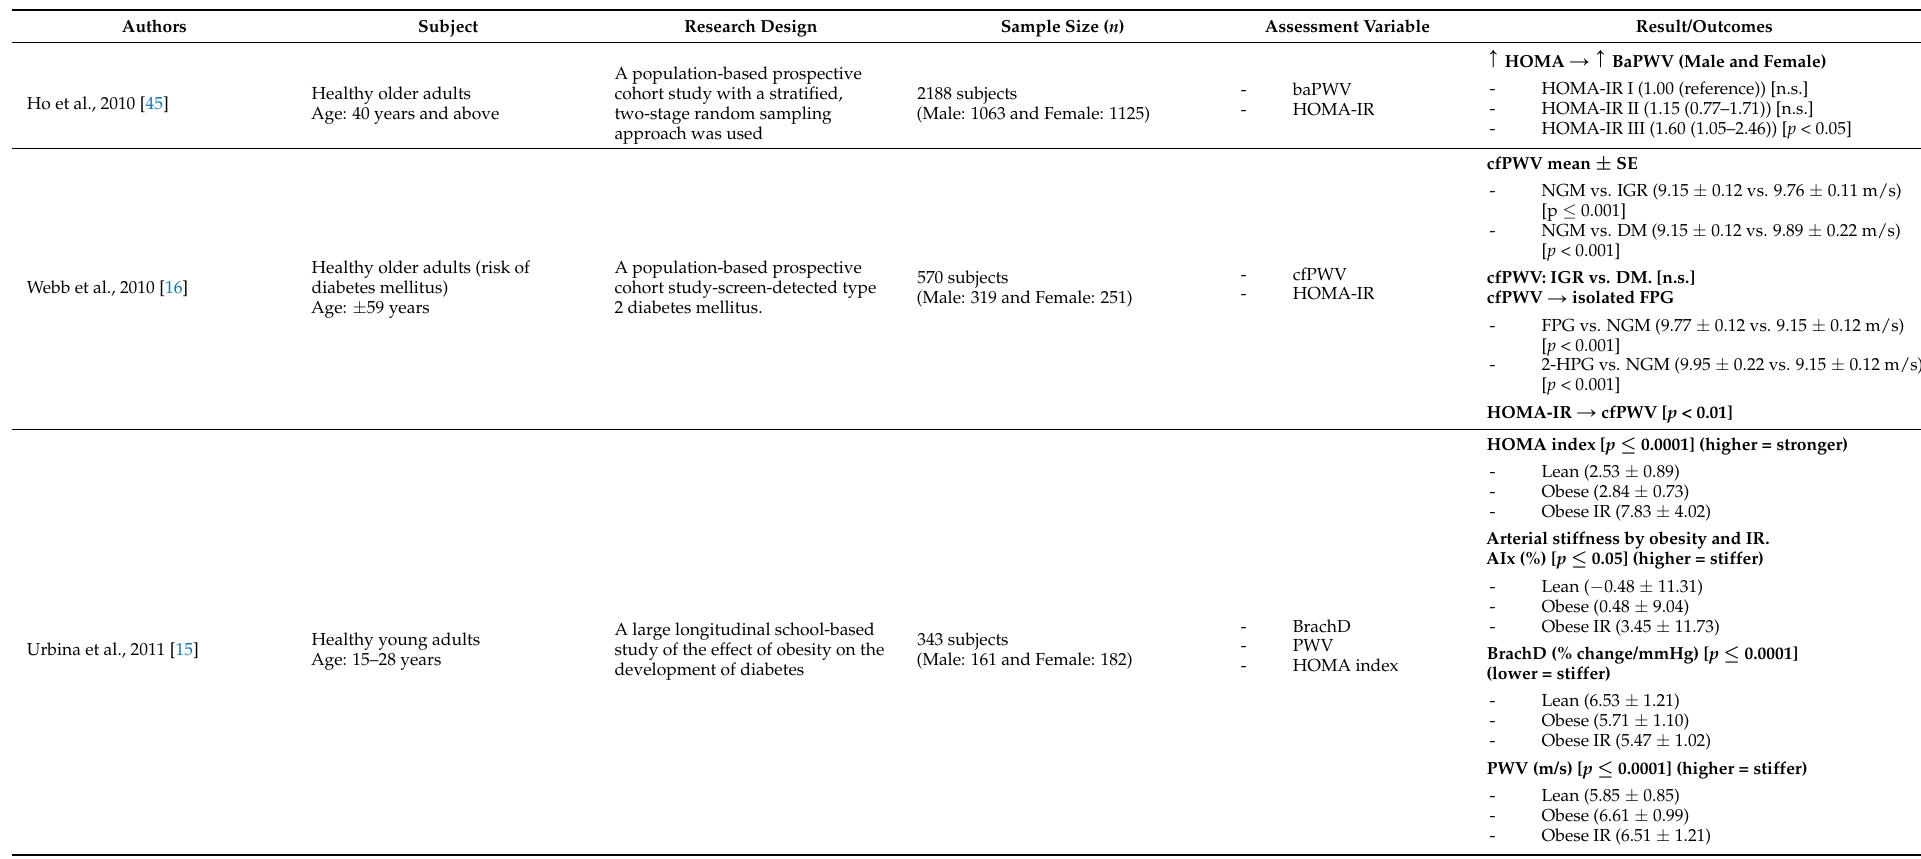
Table 1. Summary of the associations between metabolic impairments and arterial stiffness.